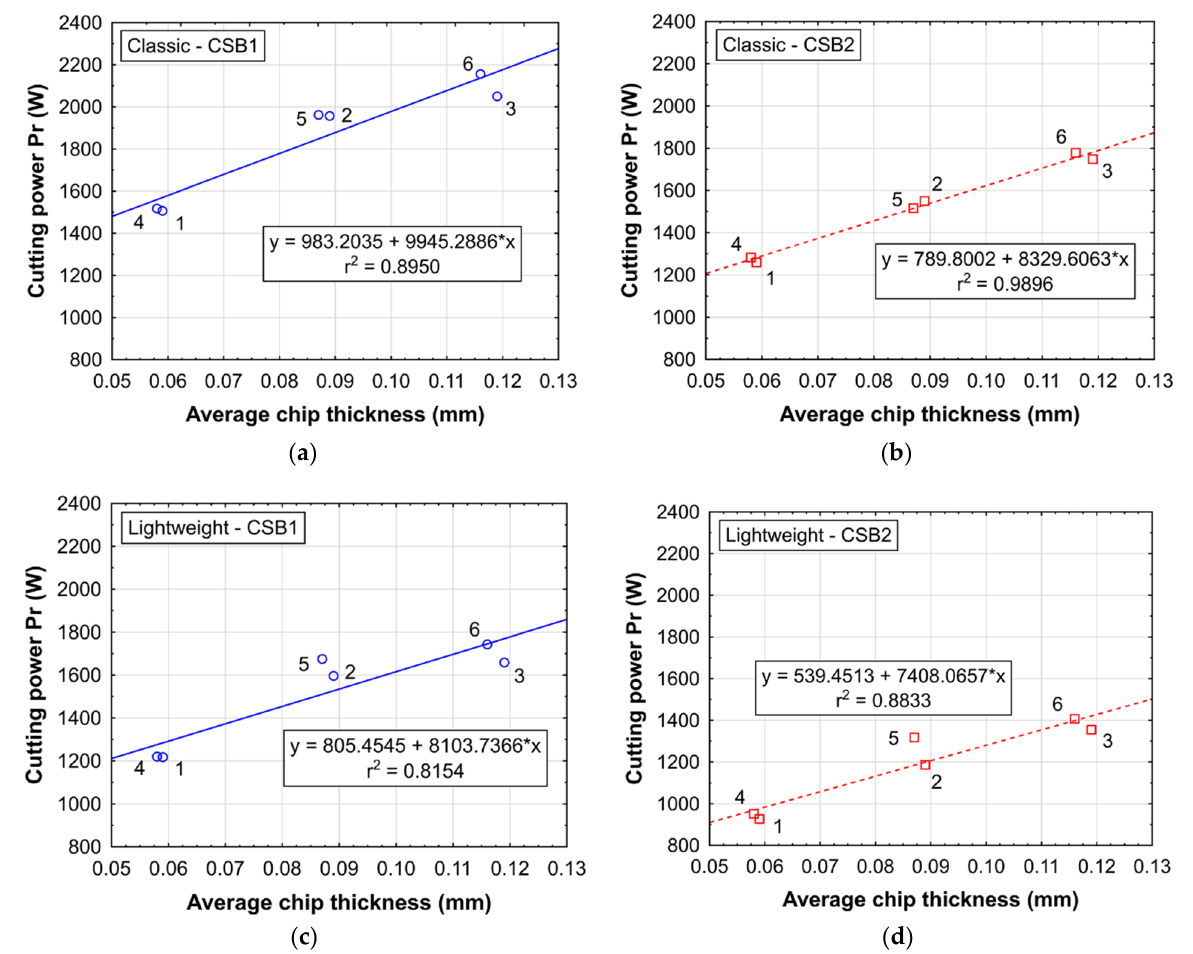
Figure 8. Cutting power depending on average chip thickness for classic and lightweight plywood and different CSB: ( a ) classic plywood—CSB1; ( b ) classic plywood—CSB2; ( c ) lightweight plywood—CSB1; ( d ) lightweight plywood—CSB2.